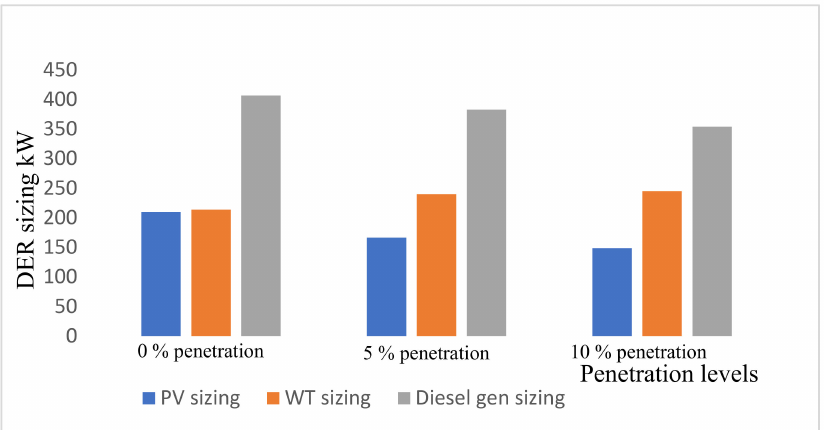
Figure 19. Sizing of sources without considering the uncertainty in